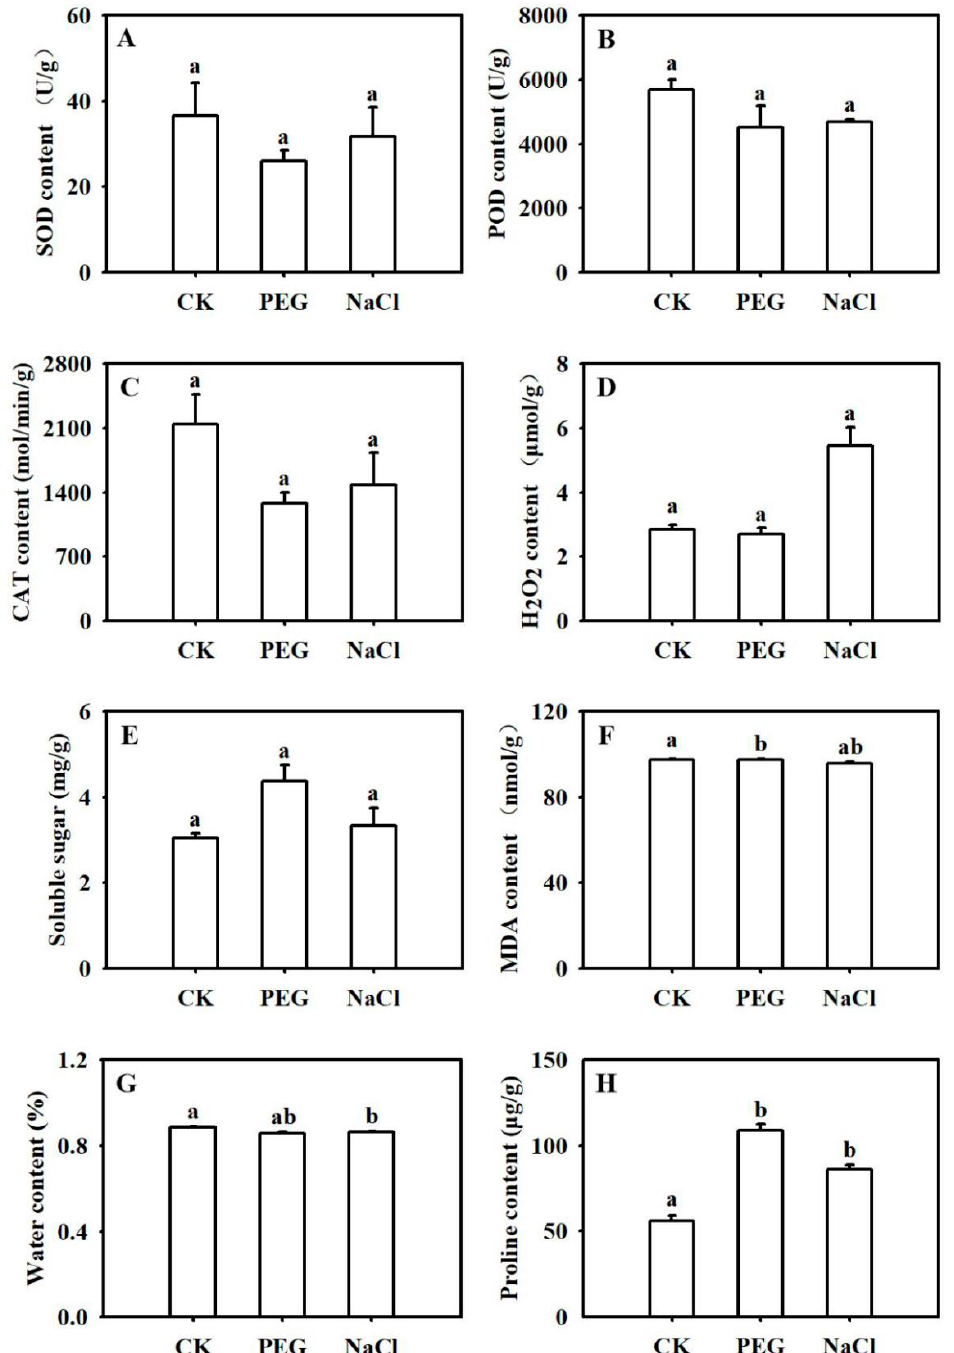
Figure 1. Effects of drought and salinity stress on physiological and biochemical parameters in B. napus . Superoxide dismutase—SOD ( A ), peroxidase—POD ( B ), catalase—CAT ( C ), H 2 O 2 ( D ), soluble sugar ( E ), malondialdehyde—MDA ( F ), water ( G ), and proline—PRO ( H ) contents were determined after 3 h of drought (simulated by polyethylene glycol (PEG)) or salinity (NaCl) treatment. CK represents the control group, (i.e., seedlings treated with ½ Hoagland nutrient solution); PEG represents seedlings treated with 15% ( w / v ) PEG 6000 plus ½ Hoagland nutrient solution for 3 h. NaCl represents seedlings treated with 150 mM NaCl plus ½ Hoagland nutrient solution for 3 h. Each data point represents the mean of three samples ± SE. Columns with different letters in each graph indicate significant differences based on Duncan’s multiple range tests at p < 0.05 among treatments.